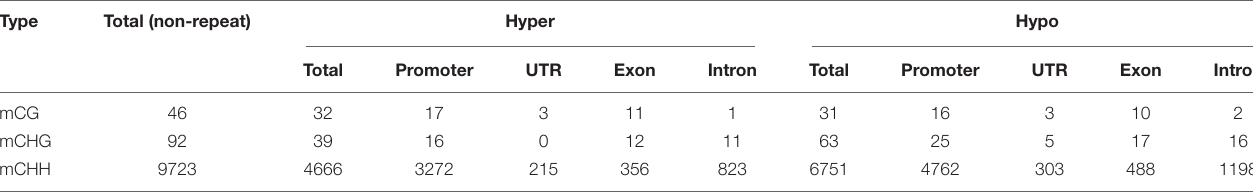
TABLE 3 | Number of hyper- and hypo-DMGs of three contexts in gene functional regions. Type Total (non-repeat)